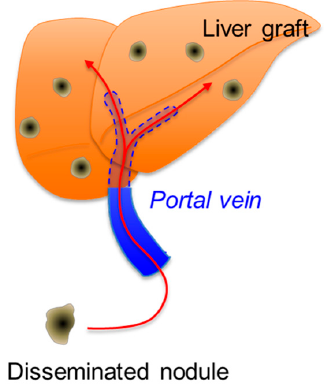
Figure 5. A schematic illustration of the hypothesized mechanism of recurrence in this patient. Multiple metastases in the liver graft are assumed to be derived from disseminated nodules through the portal vein.